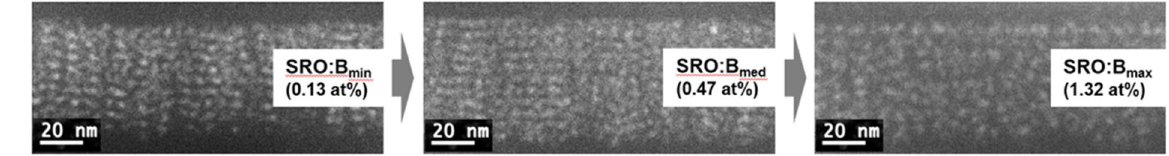
Figure 2. Influence of B on the SiO 2 viscosity. EFTEM cross-section images of 1100 °C-annealed 10-bilayer 4-nm-SRO:B/2-nm-SiO 2 SLs, filtered around the Si-plasmon loss energy. The layered structure is well preserved for the lowest and the medium B-concentration but the NC-stacking order is less clearly pronounced for the highest B-concentration. Obviously, the threshold for SL-preservation and thereby for NC size-control is slightly above 1 at% B.